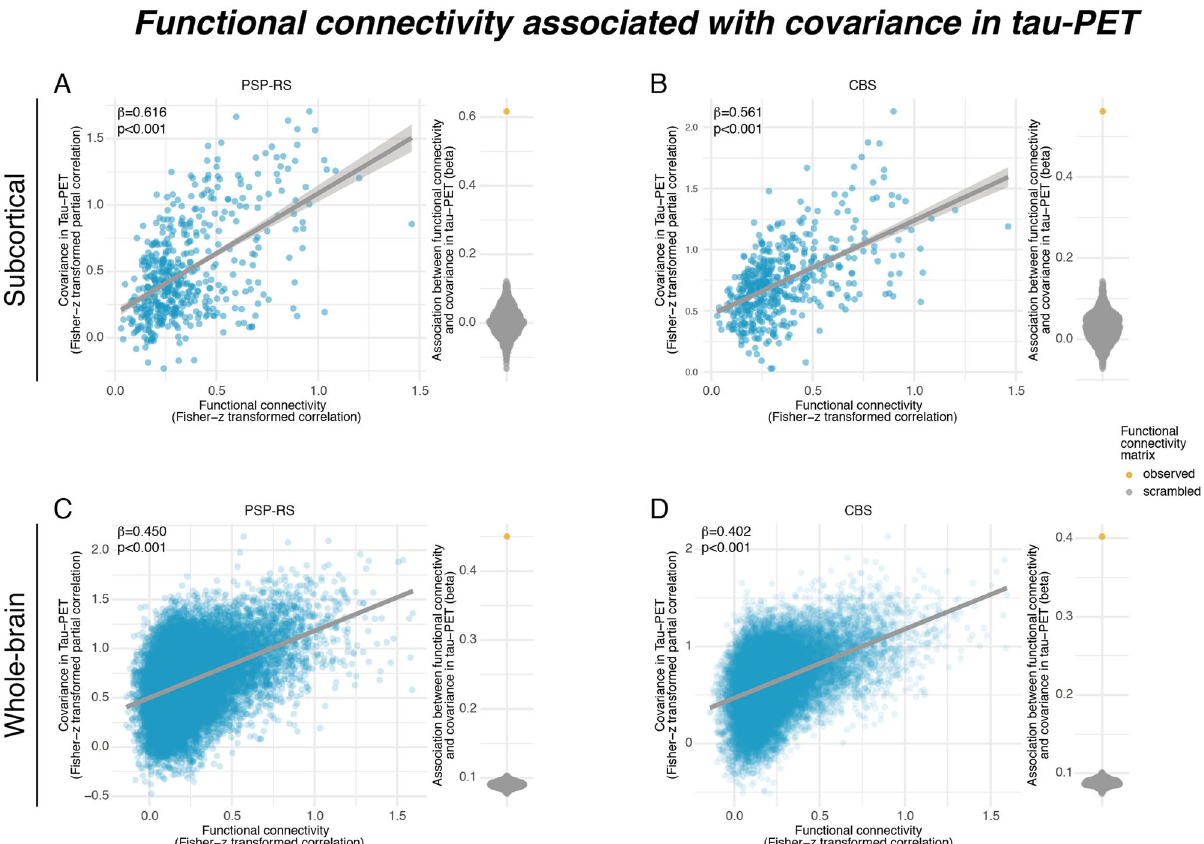
Fig. 4 Association between connectivity and covariance in tau-PET. Scatterplots illustrating the association between functional connectivity and covariance in 18-F-PI2620-PET among subcortical regions in progressive supranuclear palsy — Richardson syndrome (PSP-RS, A ) and cortico-basal syndrome (CBS) groups ( B ), as well as among subcortical and cortical regions for PSP-RS ( C ) and CBS groups ( D ). Standardized beta- and p -values were derived from linear regression controlling for Euclidean distance between regions of interest (ROIs). Beeswarm plots illustrate the distribution of standardized beta-values derived from repeating the analysis 1000 times using scrambled connectomes with preserved weight- and degree distribution (gray points) vs. the beta-value derived from the association with the actual observed connectivity matrix that is illustrated in the scatterplot (yellow point). Two-sided p -values have been determined via linear regression. Linear model fi ts are indicated together with 95% con fi dence intervals. Source data are provided as a Source Data fi